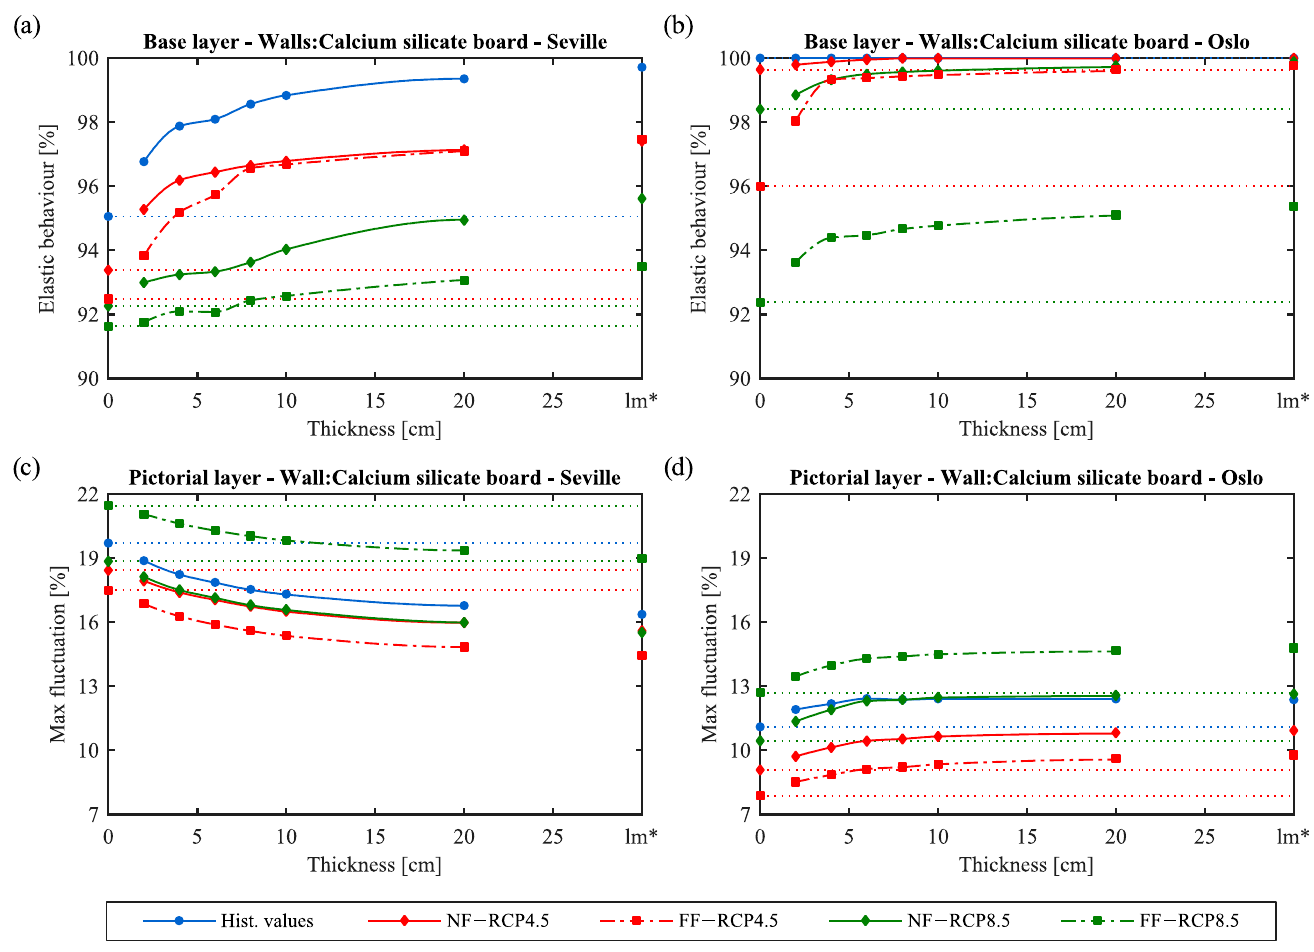
Figure 6. Mechanical decay assessment for the base layer of panel paintings for the case study with calcium silicate board for Seville ( a ) and Oslo ( b ); and mechanical decay assessment for the pictorial layer of panel paintings for the case study with calcium silicate board for Seville ( c ) and Oslo ( d ). This figure shows the results for historical, near-future, and far-future time frames for the case study with a wall retrofit measure and for the case without retrofits (dotted lines). lm* is an additional “virtual” thickness that corresponds to a 30 cm